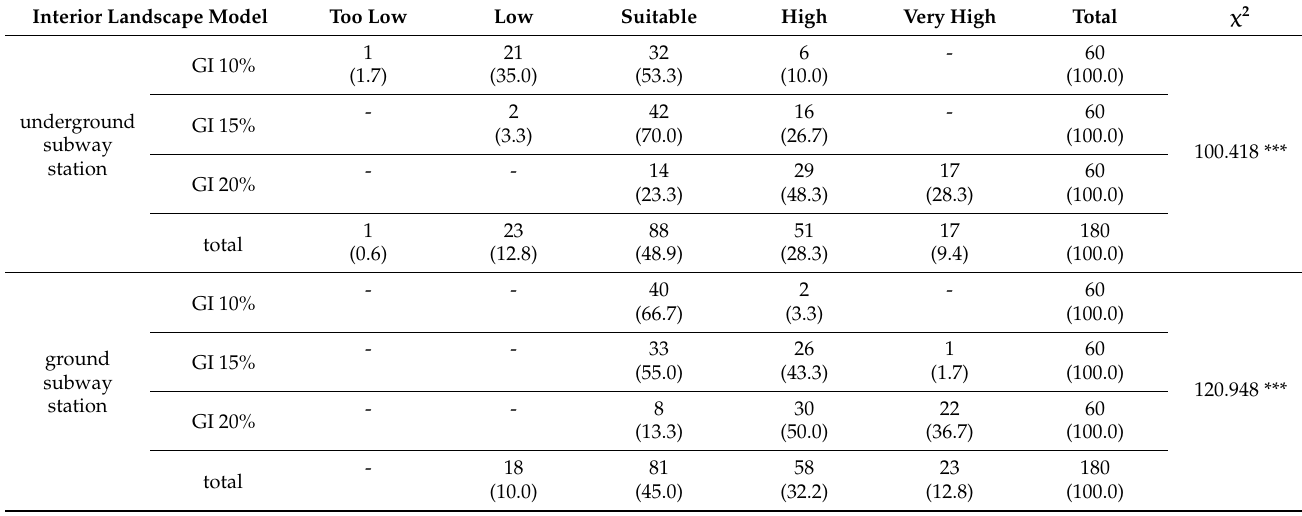
Table 7. Analysis of Level of Interior Landscape Area Recognition of Interior Landscape Models in Subway according to GI. Interior Landscape